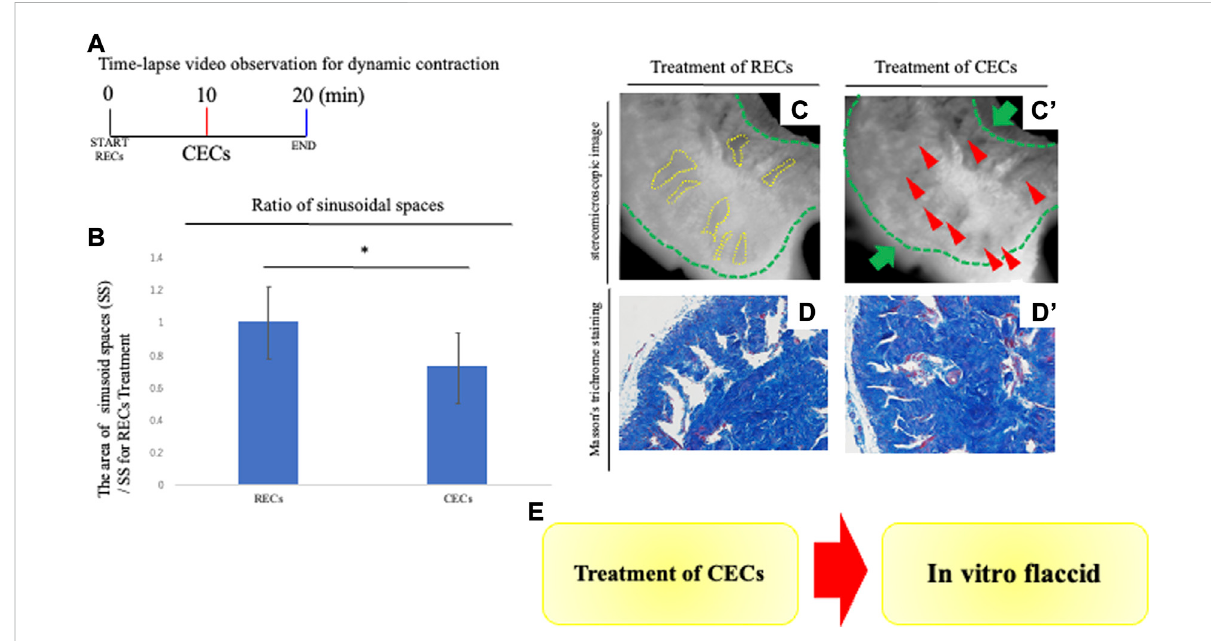
FIGURE 3 Analysisofpenilecontractionresponses. (A) Time-lapsevideoobservationcriteriafordynamiccontraction.Foranalyzingthecontractionofthe CC, contraction-enhancing compounds (CECs) were treated to induce vasoconstriction after 10 min of the treatment of RECs. After CECs treatment, time-lapse pictures were taken for 10 min. CECs were in the fi nal concentration of each reagent; 1.0 μ M PE and 0.1 μ M endothelin-1. A time-lapsevideoanalysiswasperformedbyImageJsoftware. (B) Graphwascalculatedfromimagesofthemovieandindicatestherelativearea ofsinusoidalspacesbytheprominentphaseofthemovie.TheCCwithtreatmentofCECswassigni fi cantlydecreasedinitssinusoidalsizecompared withtreatmentofRECs. (C,C 9 ) Representative8-bitimagesofthePBdye-stainedCCduringcontractionresponses.ManysinusoidalspacesintheCC are indicated by yellow dotted lines. From sequential images (interval time was 10 s), the boundaries of sinusoids were marked and the sinusoidal spaces were calculated after RECs/CECs treatment by ImageJ software. We compared the area of sinusoids at each time point (the time point for RECs treatment and CECs treatment). Contraction was represented as a ratio of the treated area of sinusoid RECs to that of CECs. The whole CC (indicated by the green dotted line and arrow) was contracted, as well as the sinusoidal space. The red arrowheads showed that the collagen area contracted by the treatment of the CECs (see Supplementary Movie S2). Scale bar 100 μ m. (D,D 9 ) Image of Masson ’ s trichrome staining of the CC showingthecollagen-richregions.Similartothetime-lapseimages,thesinusoidalspaceswerereducedaftertreatmentwithCECs,andthecollagen area was contracted toward the central region. Scale bar 50 μ m. (E) Schema shows the reproduction of the ‘ fl accid state ’ by the current system. The contractive movement was in the opposite direction to that observed by the treatment of the RECs; the expanded cavernous space prominently contracted.TheextendedcollagenregionsbytheRECtreatmentcontractedinthedirectionofthedeeparteries.Thecollagenregionsnearthedeep arteries did not show signi fi cant movement when contraction was induced by the subsequent CECs. These results suggest that the “ erectile state ” reproduced by the REC treatment is characterized by the return to the “ fl accid state. ” All data shown are representative results of at least three independent experiments using adult specimens from different litters (n ≥